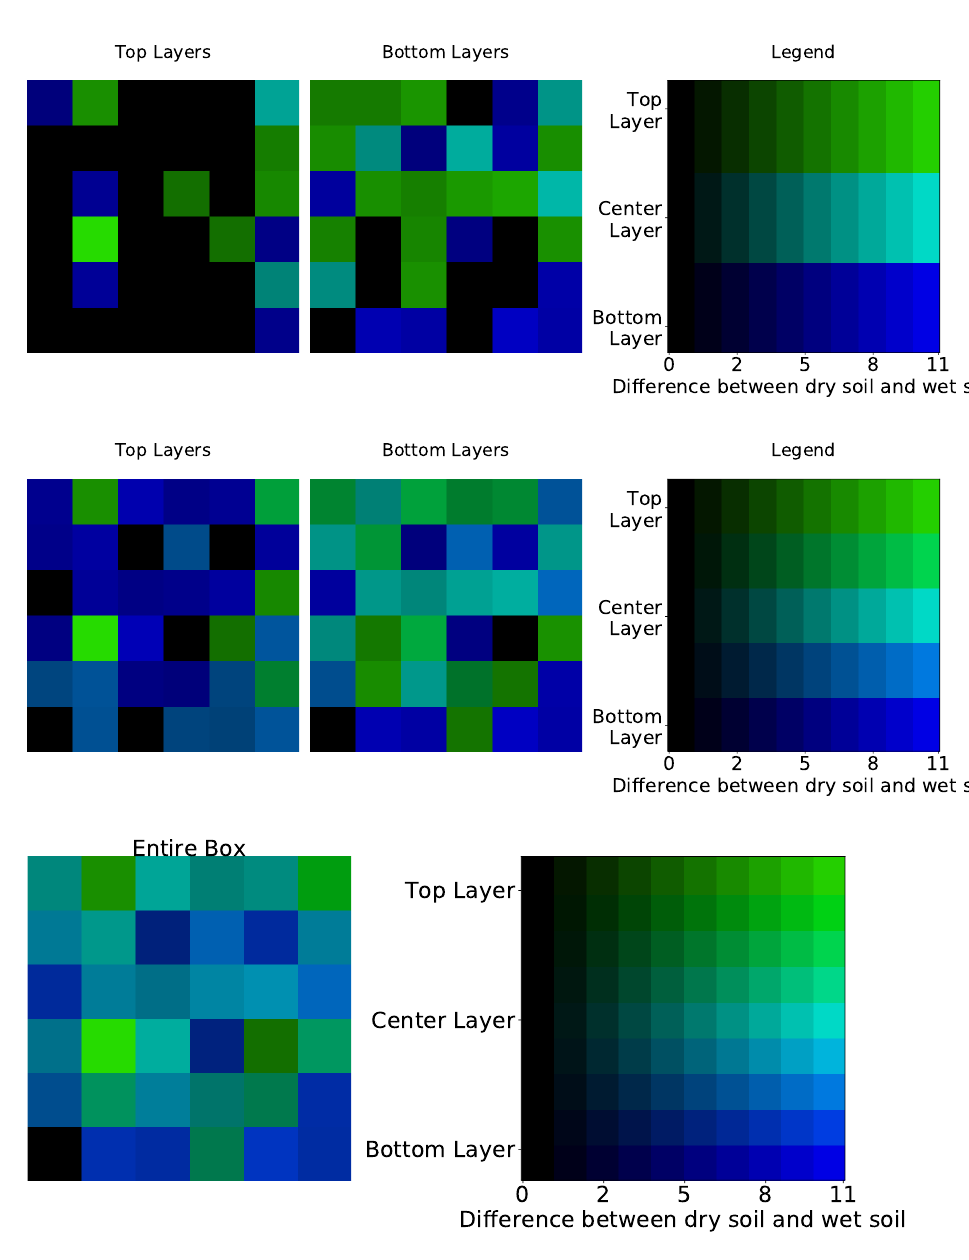
Figure 8. RADAR’s readings representation on PondView with nine